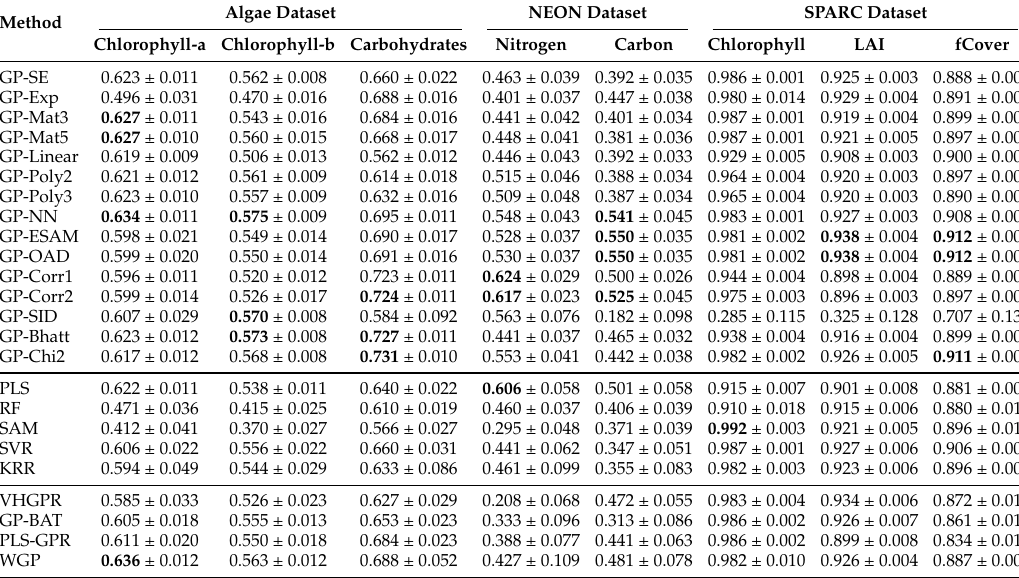
Table 3. Predictive performance of different methods on all three datasets measured in R 2